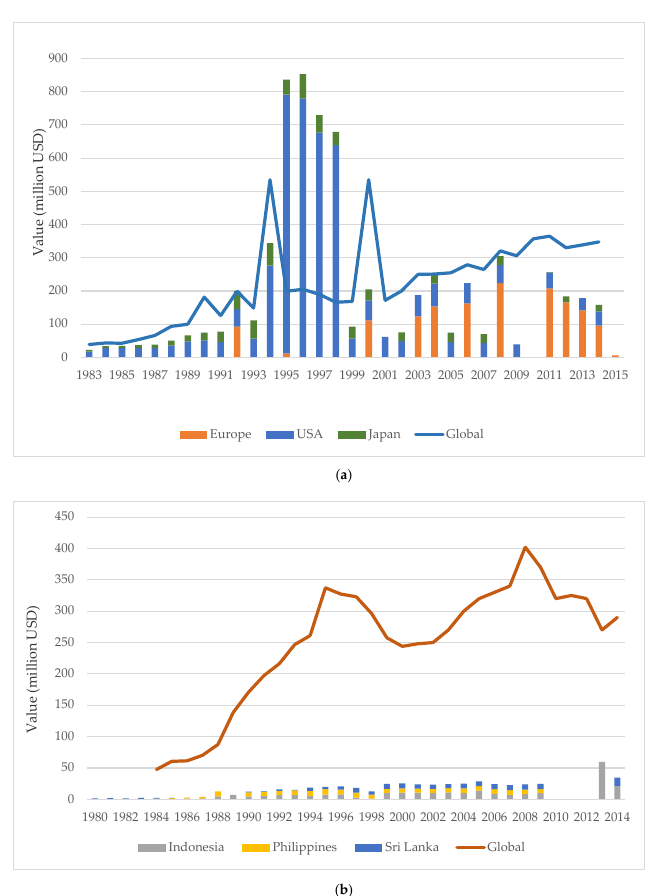
Figure 4. ( a ) Average wholesale value in million USD of freshwater and marine fishes for the global export compared with import to Europe, the United States, and Japan [4,7,12,15–17,29,33, 34,36,37,40,41,43,44,46,48,49,51–59]. ( b ) Average wholesale value in million USD of freshwater and marine fishes for global import compared with exports from Indonesia, the